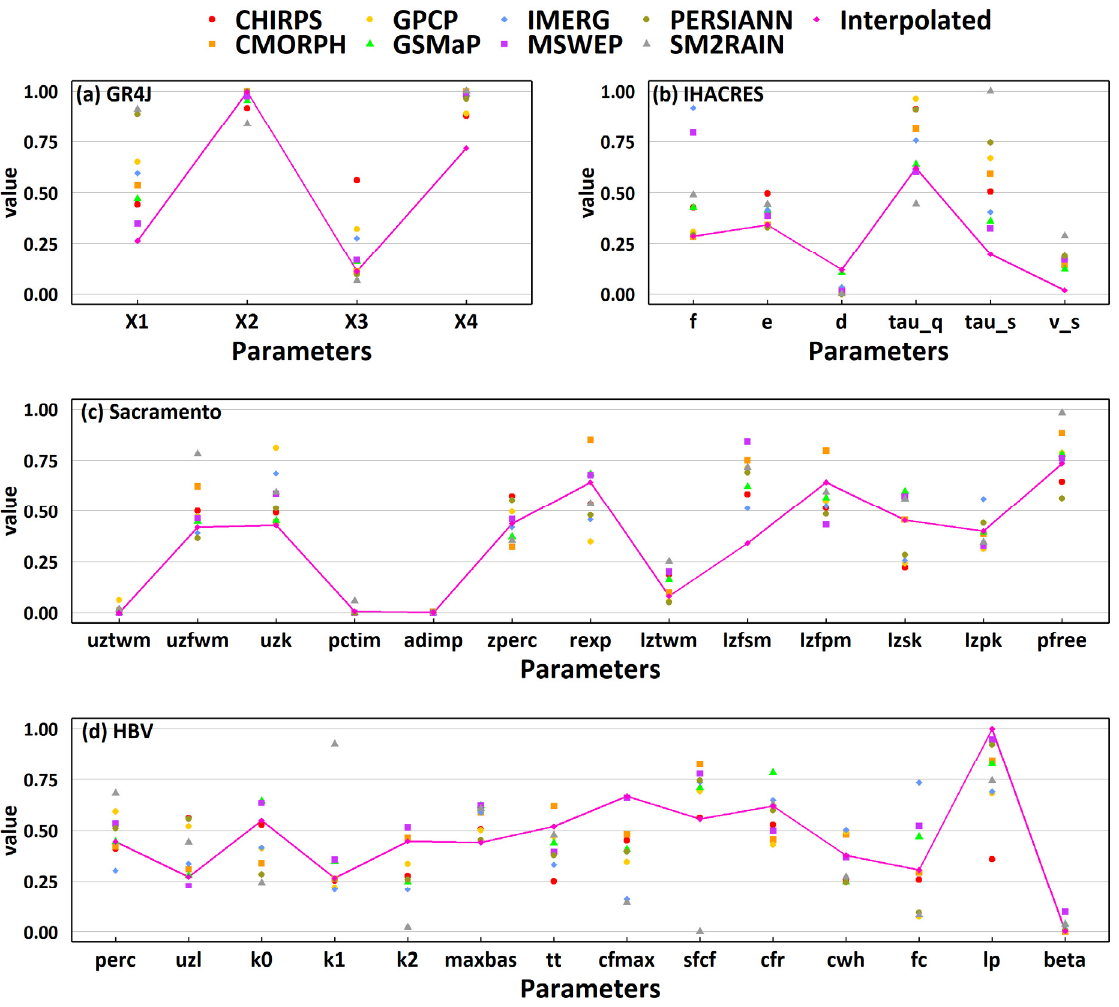
Figure 9. Distribution of normalized optimal hydrologic parameters with different precipitation inputs for the various hydrologic models. The optimal parameter combination for each calibrated hydrologic model driven by different precipitation products is represented with a different coloured mark. In addition, the optimal hydrologic parameters combination driven by the rain gauge observa- tion interpolation are plotted with a magenta mark and line for